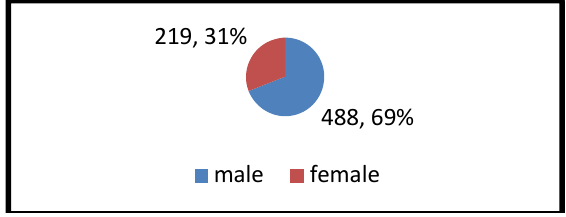
Fig 1. Gender distribution The mean age was 51.3years. Age range was 30-76 years. Right coronary artery was dominant in 83%,